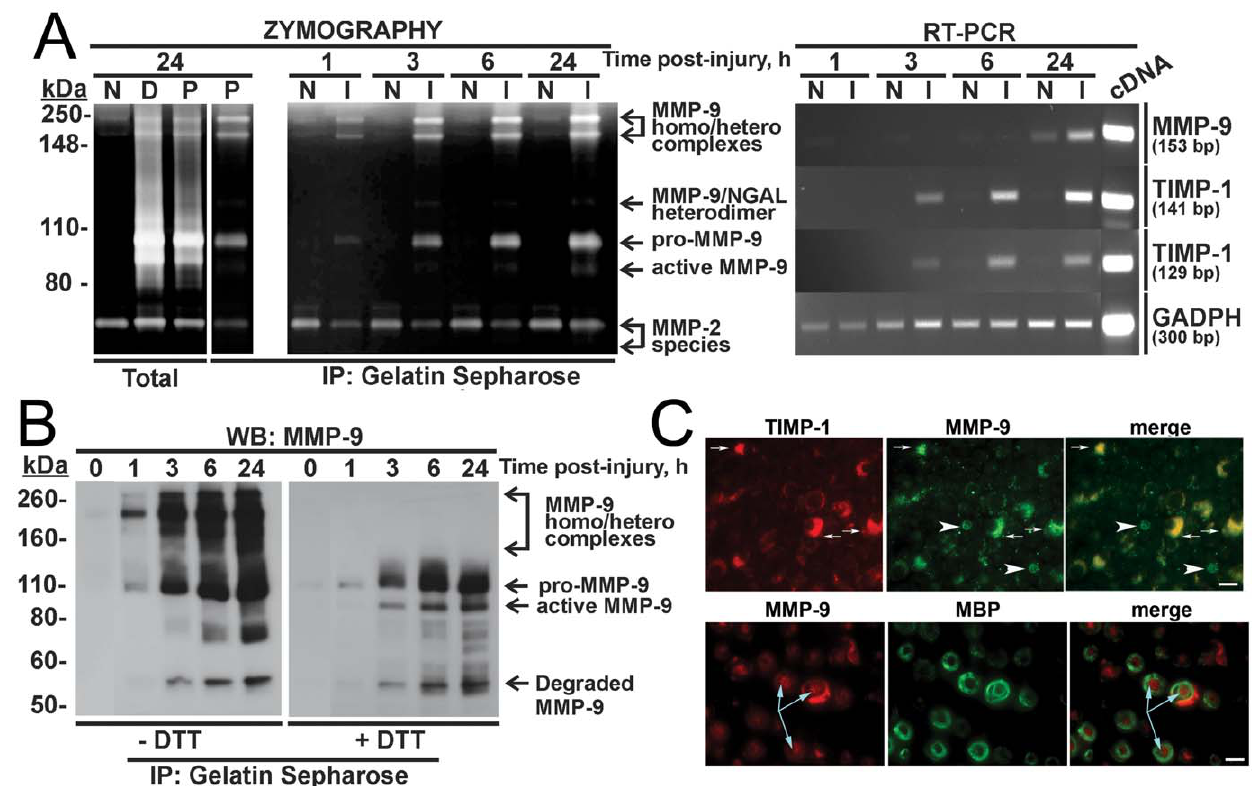
Figure 4. MMP-9/TIMP-1 relationship in the sciatic nerve. A, Left, Multiple murine MMP-9 species are detected by gelatin zymography. The total extracts (10 m g total protein each) of the naı¨ve (N), distal (D) and proximal (P) segments of the transected nerves were analyzed by gelatin zymography. Right lane, the purified MMP-9 sample isolated from an aliquot (25 m g total protein) of the proximal nerve extract (P) is provided as a reference. Middle, the purified MMP-9 samples isolated from the naı¨ve (N) and crushed (I) nerve (50 m g and 25 m g total protein, respectively) 1, 3, 6 and 24 h post-injury were analyzed by gelatin zymography. Note a 2 6 protein loading of the naı¨ve samples relative to the injured samples. Right, 2% agarose gel-electrophoresis of the RT-PCR products. The MMP-9 and TIMP-1 genes were amplified using the naive and crushed samples in the RT-PCR reactions. The unique primers were used in a 35-cycle PCR reaction to generate a 153 bp MMP-9 fragment, and 129 bp and 141 bp TIMP-1 fragments. GAPDH was used for sample normalization. Right lane (cDNA), the first strand cDNA control synthesized from the total mouse spleen RNA in the RT- PCR reaction. B, High molecular weight forms of MMP-9 in the injured sciatic nerve. The reduced ( + DTT) and unreduced ( 2 DTT) purified MMP-9 samples (15 m g total protein each) isolated from the injured sciatic nerve 0, 1, 3, 6 and 24 h post-injury were analyzed by Western blotting with the MMP-9 antibody. C, Immunofluorescence for MMP-9 and TIMP-1 co-localize in mSCs of crushed nerve 24 h post-injury. Upper panel, MMP-9 (green) and TIMP-1 (red) co-localize in crescent structures of mSCs (arrows). Circular structures are MMP-9 but not TIMP-1 reactive (arrowheads). Lower panel, MMP-9 (red) localizes in the cytoplasm of mSCs, marked with MBP (green). MMP-9 is also detected in axoplasm of mSCs (arrows). Scale bar, 10 m m.